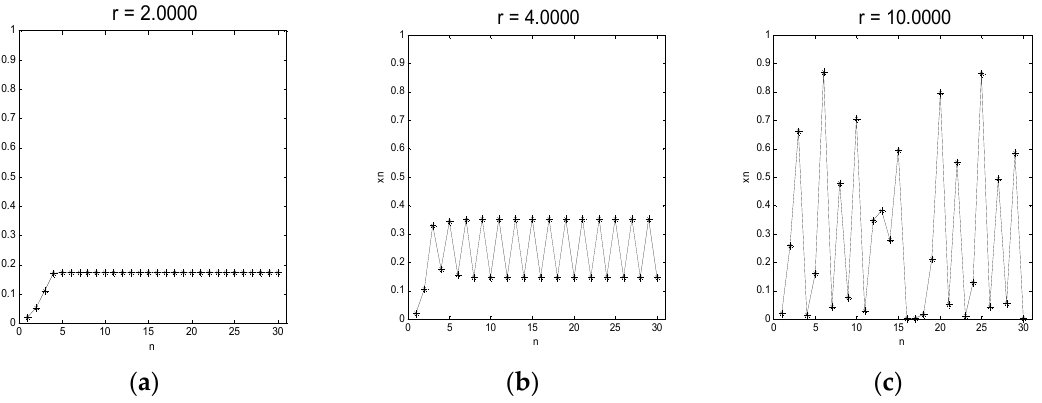
Figure 5. Iteration property analysis of modified logistic map at X 0 = 0.02. ( a ) at r = 2, ( b ) at r = 4, ( c ) at r = 10.